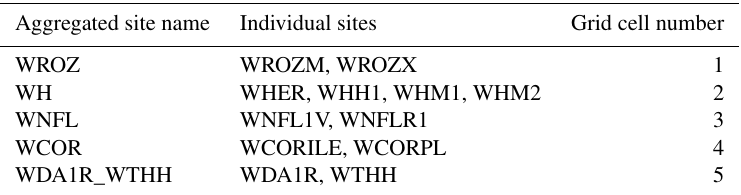
Figure 1. Location of (a) 21 Eastern Canadian taiga sites (20 sites from Nicault et al., 2014, and Boucher et al. (2017) and 1 site called here QC_taiga from Gennaretti et al., 2017) (b) aggregated Eastern Canadian taiga sites from Nicault et al. (2014) and Boucher et al. (2017) based on a 1 ◦ grid (red numbered grid cells). Background map from Hunter (2007). Table 1. Aggregated Eastern Canadian taiga sites based on the individual sites from Nicault et al. (2014) and Boucher et al. (2017) (Fig. 1a and